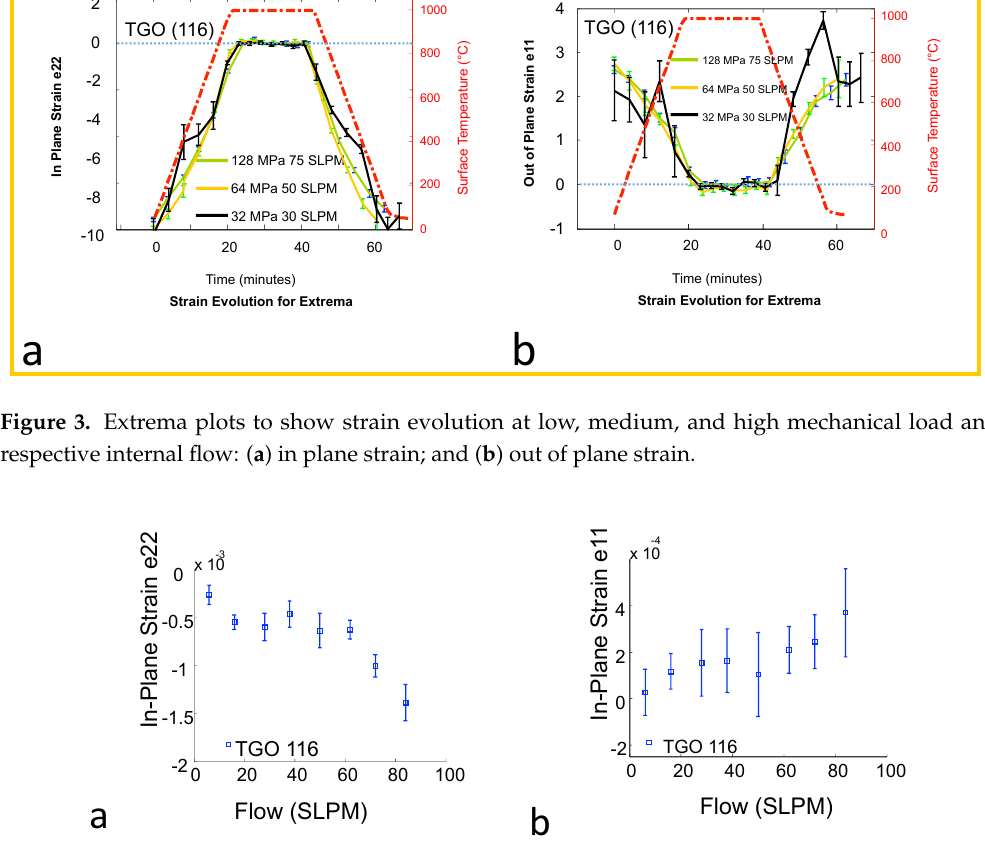
Figure 4. Variation of e22 ( a ) and e11 ( b ) TGO strain at 1000 ◦ C high temperature hold as a function of internal coolant